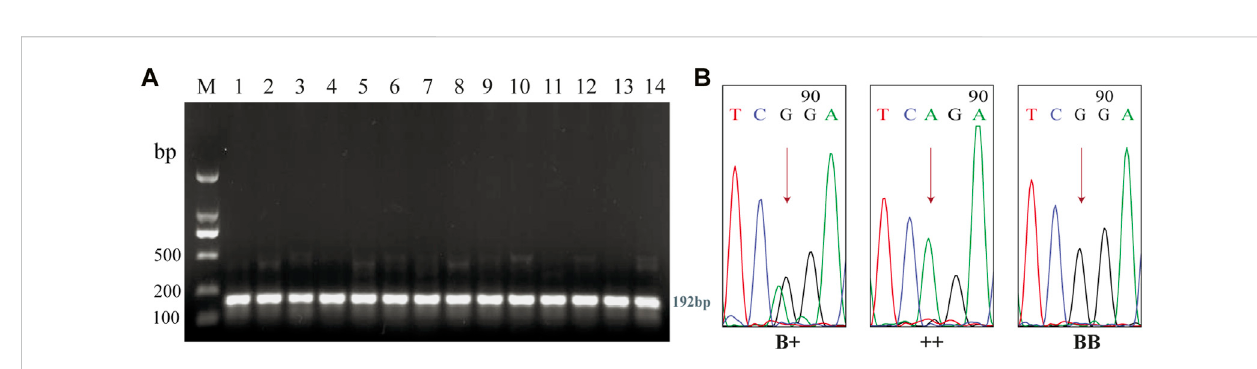
FIGURE 6 PCRampli fi cation andsequencingofBMRPR1B. (A) ,Detection ofPCRampli fi cationproductsofBMPR1Bgene inPRS.M, DL2000DNAMarker. 1-14, PCR ampli fi cation product of BMPR1B gene. (B) , Sequencing results of the B+, ++, and BB